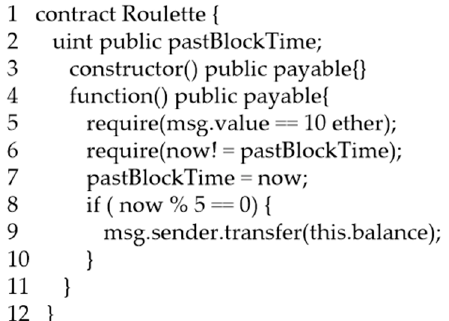
Figure 2. Timestamp dependence code of contract Roulette.